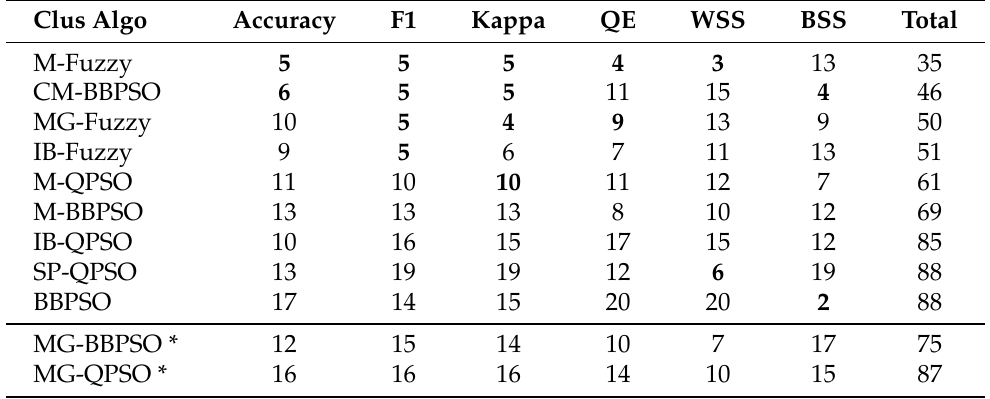
Table 6. Sum rank of algorithms based on performances on 6 metrics on CMC and Sonar datasets with best two sum rank values presented in